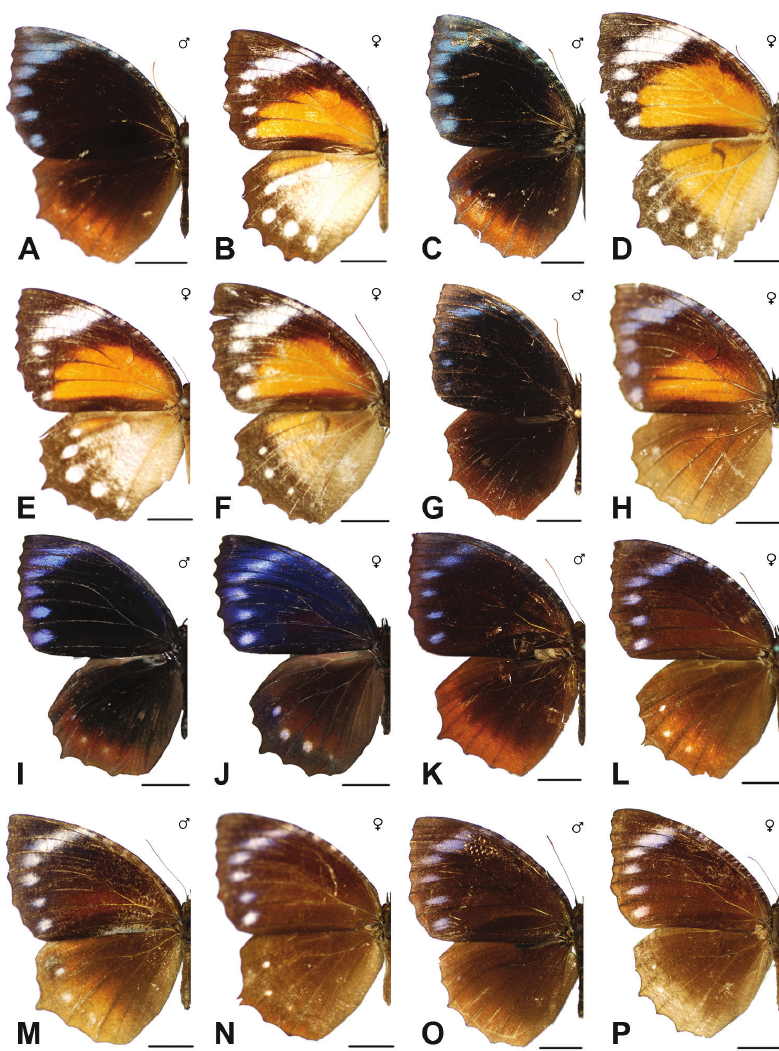
Figure 6. A hypermnestra tinctoria ♂ D NHM Myanmar: Bago B hypermnestra tinctoria ♀ D NHM My- anmar: Ayeyarwady, Pathein C hypermnestrta tinctoria ♂ D NHM Thailand: Bangkok D hypermnestra tinctoria ♀ D NHM Thailand: Bangkok E hypermnestra tinctoria ♀ D NHM Myanmar: Tanintharyi; Syntype of Elymnias hypermnestra tinctoria f. paraleuca F hypermnestra tinctoria ♀ D NHM Peninsular Malaysia: Kedah, Langkawi Island G hypermnestra discrepens ♂ D NSYSU Peninsular Malaysia: